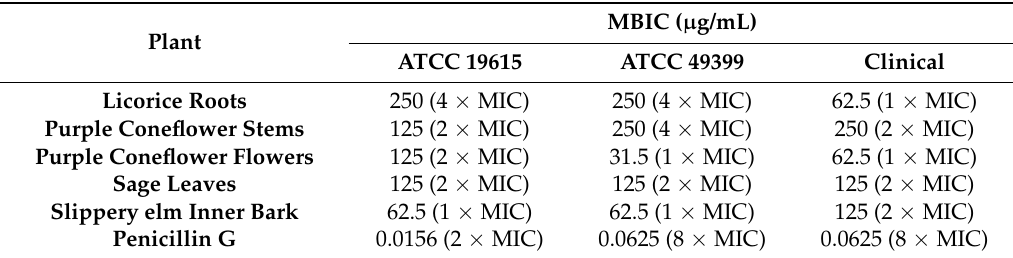
Table 3. Minimum biofilm inhibitory concentration (MBIC) of selected medicinal extracts against Streptococcus pyogenes .